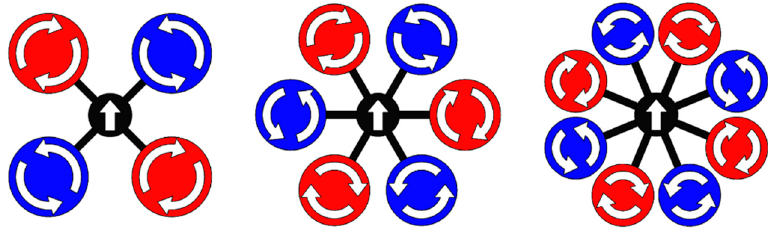
Figure 3. Conventional multirotor configurations.